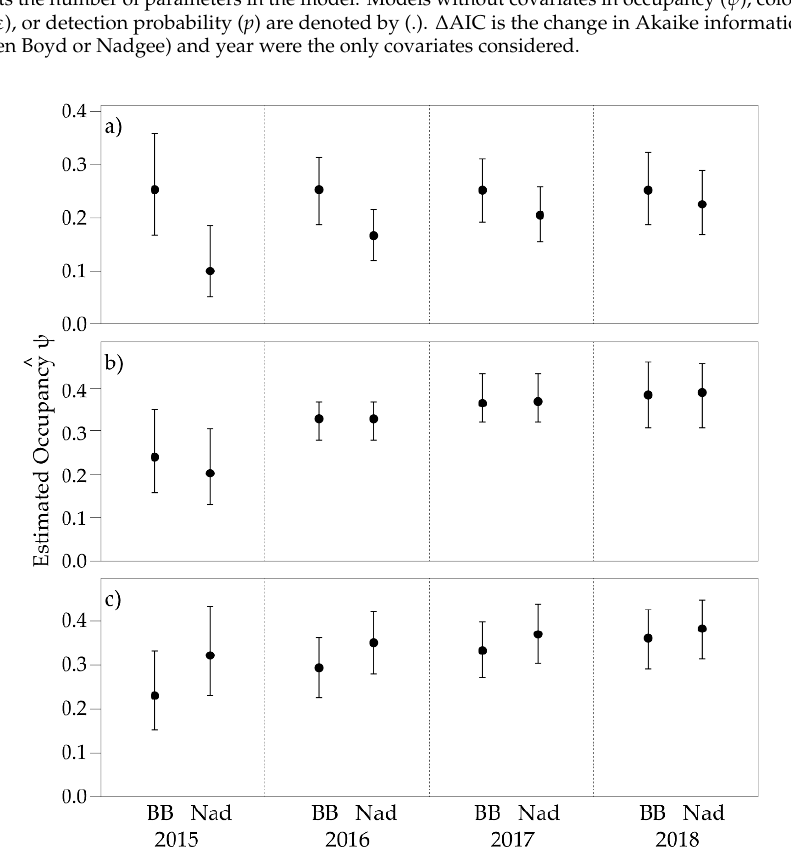
Figure 6. Multi-season occupancy estimates for ( a ) Isoodon , ( b ) Perameles , and ( c ) Potorous in Ben Boyd (BB) and Nadgee (Nad). Central mark represents the predicted estimate and bars represent the 95% confidence interval.